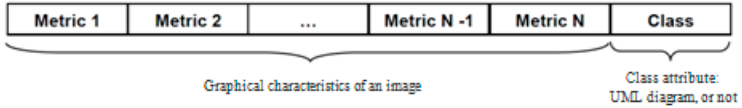
Figure 11. Format of the training instances used as input to the learning algorithm. Testing instances have the same format